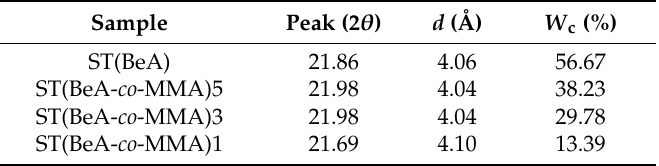
Figure 9. Wide-angle X-ray scatting (WAXS) patterns of ST(BeA- co -MMA) copolymer sheets and homopolymer ST(BeA) measured at room temperature. Table 6. The location of diffraction peak with its corresponding interplanar crystal spacing d , and crystallinity ( W c ) of ST(BeA- co -MMA) copolymer sheets and homopolymer ST(BeA) measured at room temperature.